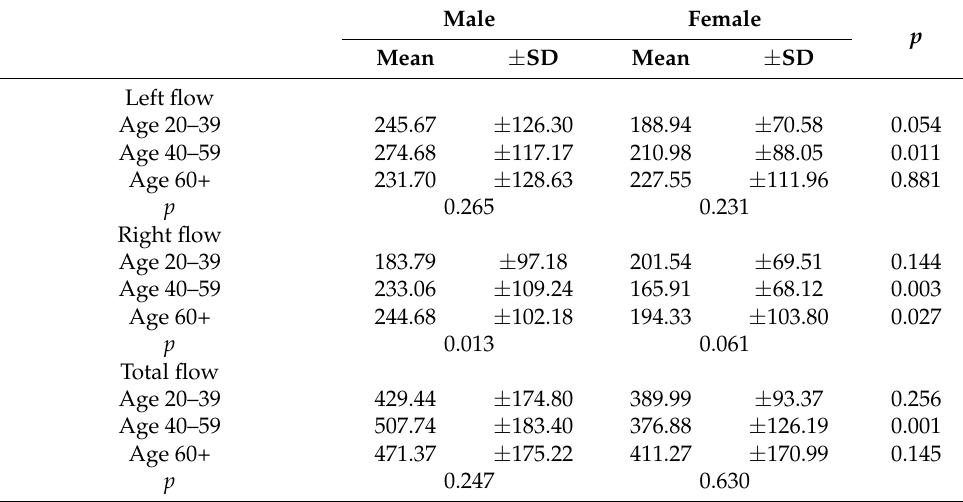
Table 2. Nasal flow (cm3/s) at a fixed pressure of 75 Pascal.